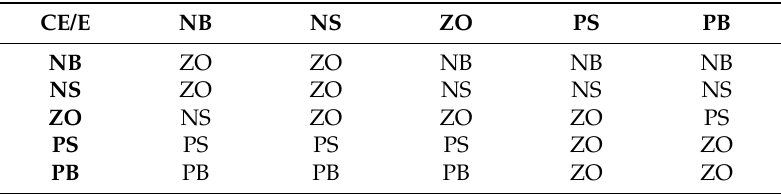
Table 1. Control rules of fuzzy associative